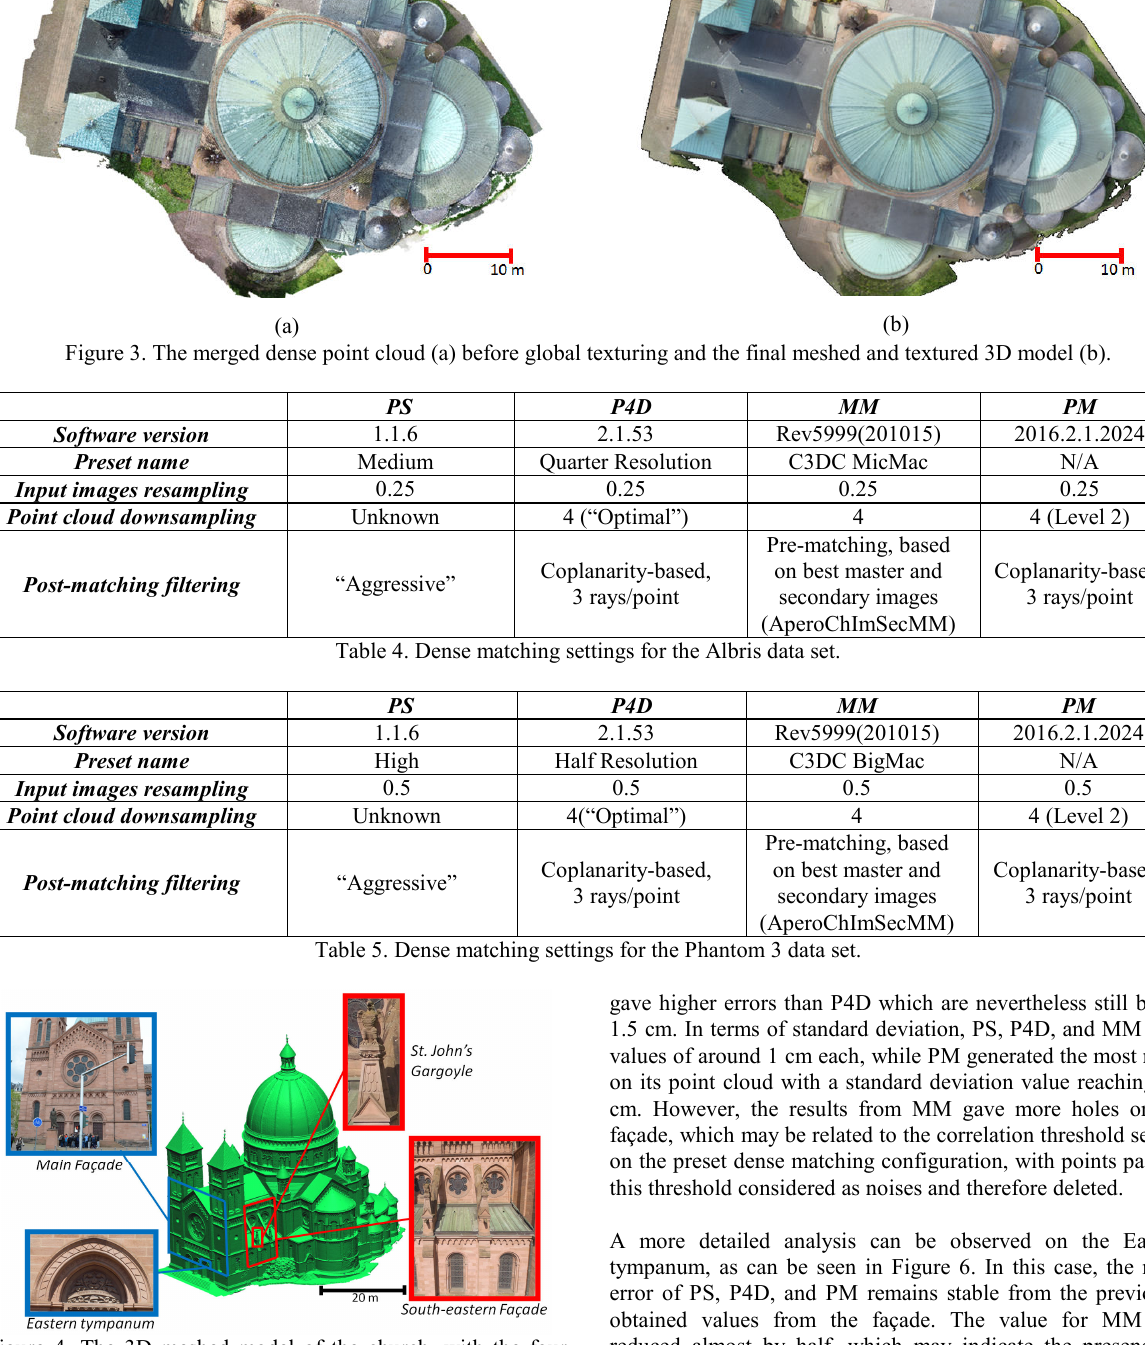
Figure 4. The 3D meshed model of the church, with the four samples taken in order to compare them with TLS data. Blue squares indicate acquisition by Albris while red squares indicate acquisition by Phantom